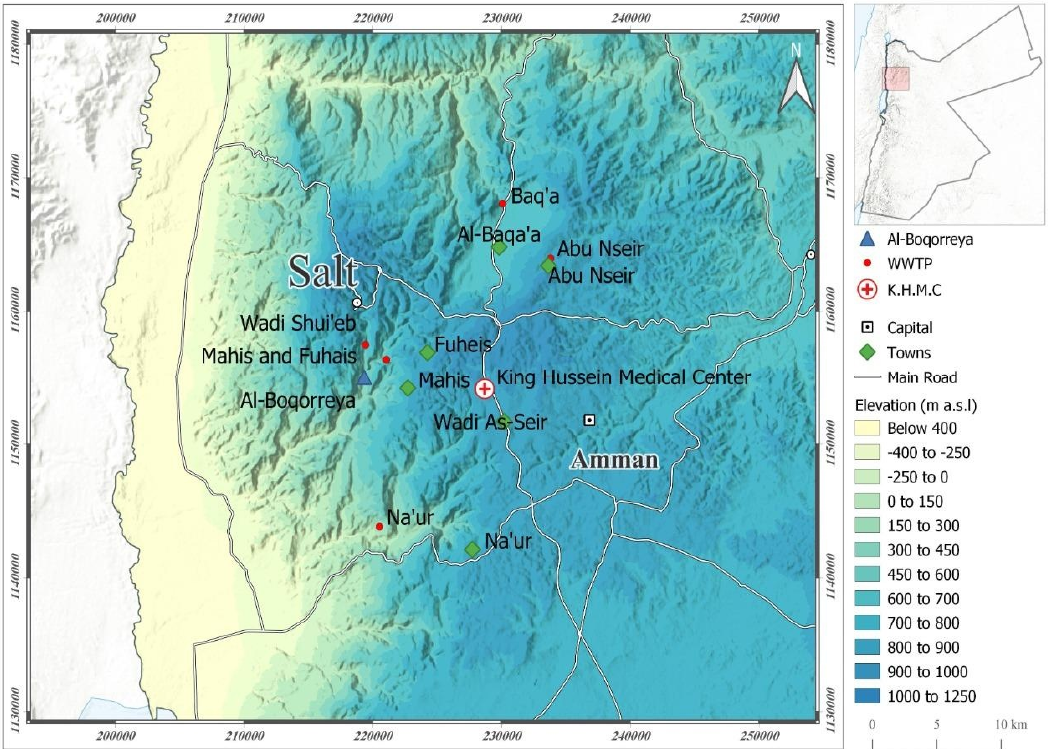
Figure 1. Location of the study area showing the wastewater treatment plants and Boqorreya spring sites. Sites of soil and plant samples lie in the downstream area of WWTPs.